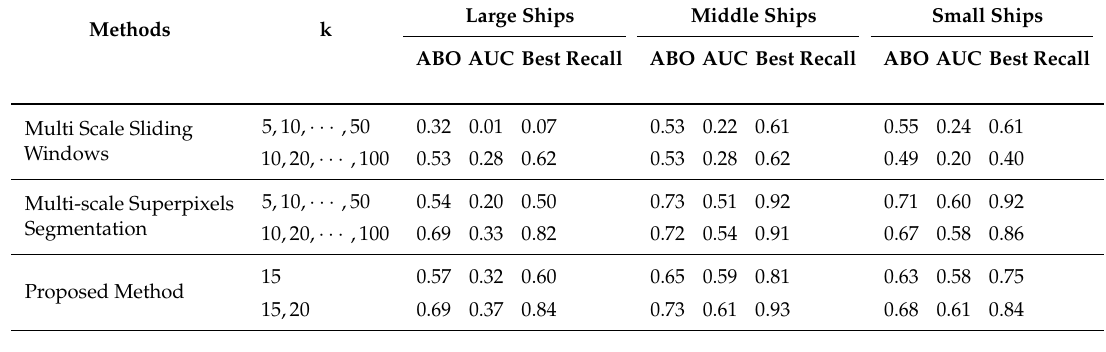
Table 2. Comparison of ABO scores, AUC and best recall for the proposed method and various variants of our approach on validation datasets that contain multi-scale ships.